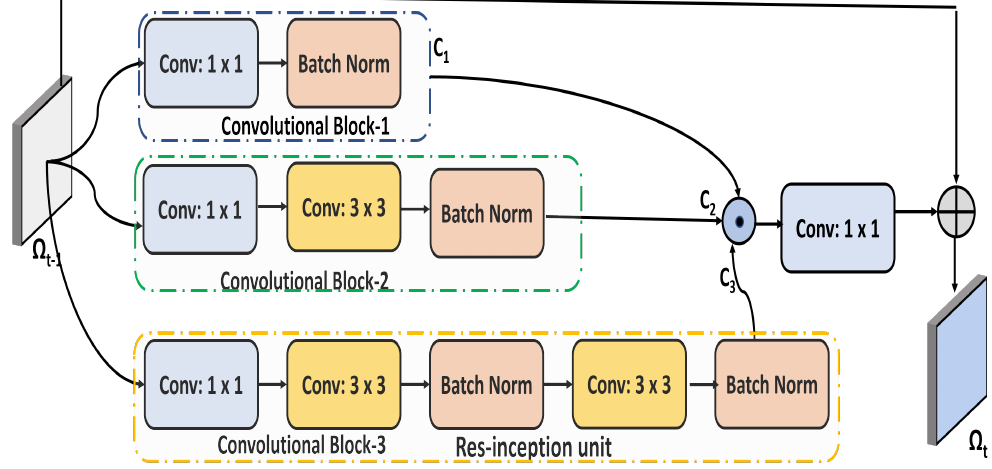
Figure 2. Structural diagram of Res-inception